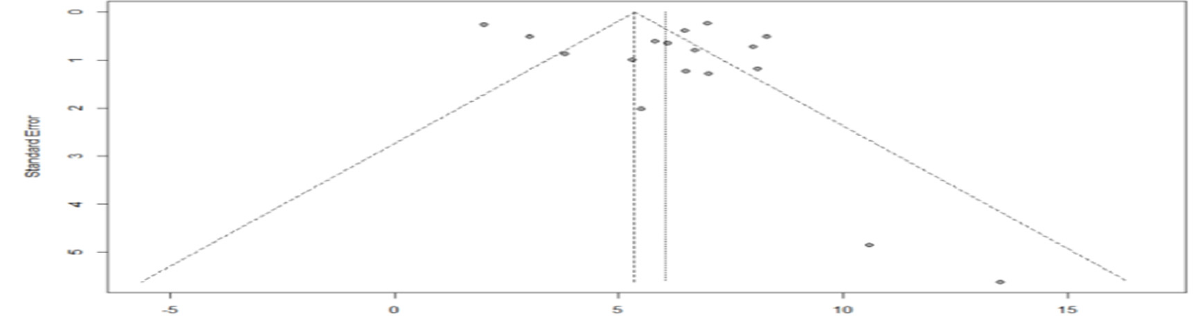
Figure 7. Funnel plot of overall survival in the targeted chemotherapy combination group compared with the chemotherapy agent alone group.